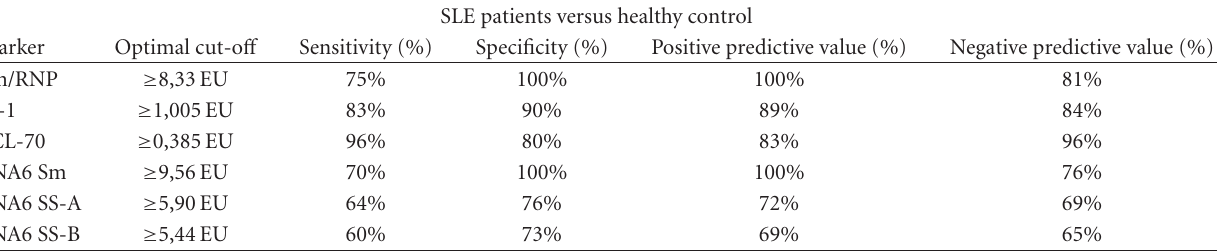
SLE: systemic lupus erythematosus; EU: elisa